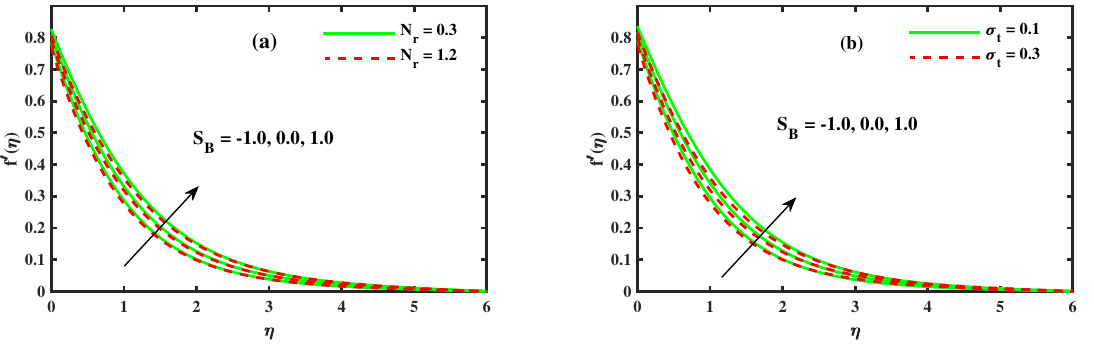
Figure 4. The impact of f (cid:48) ( η ) for ( a ) Solutal buoyancy Nr and ( b ) unsteady parameter σ t . Figure 5a,b shows the impact of the electric field parameter E I and